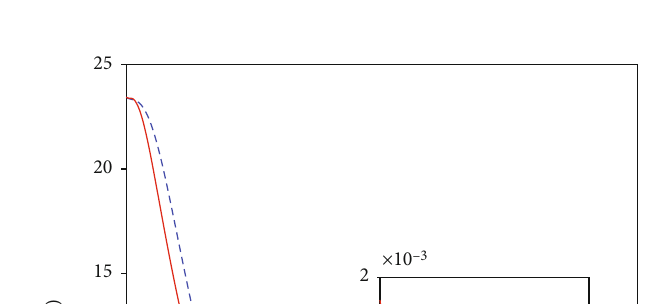
Figure 17: Estimated parameter.